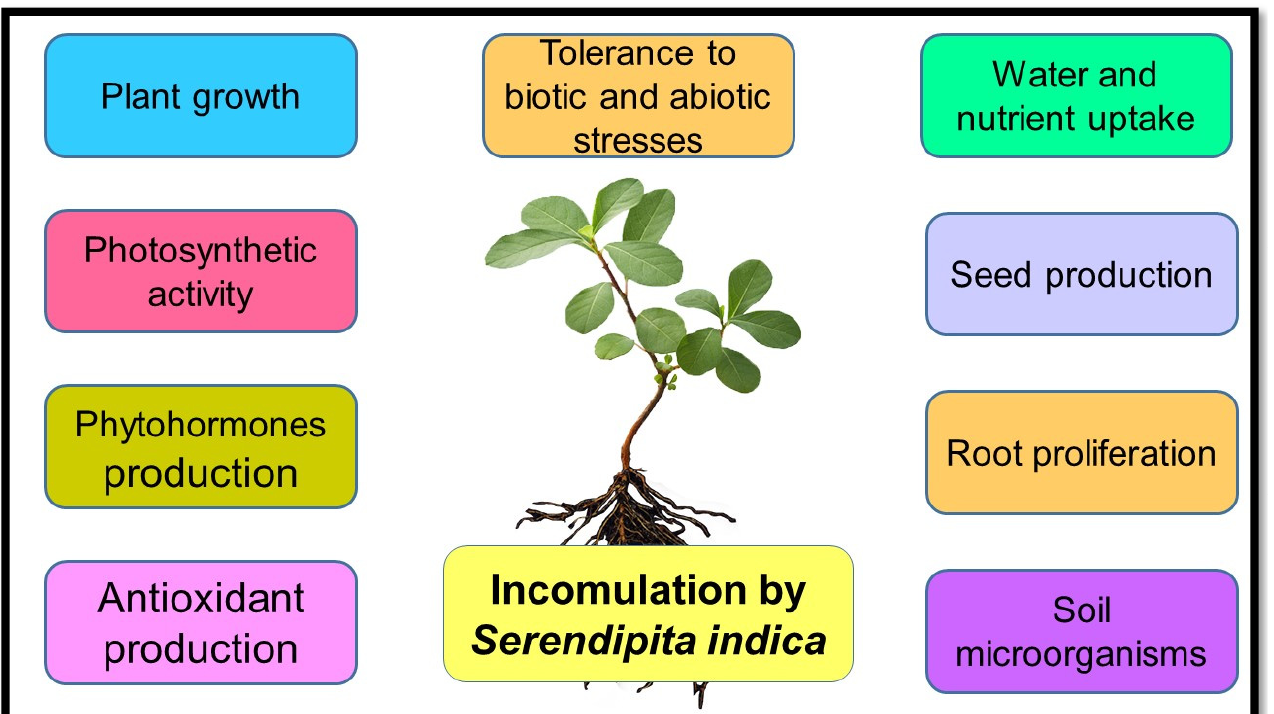
Figure 2. Positive morphological, physiological, and molecular effects of inoculation of plant roots with S. indica.